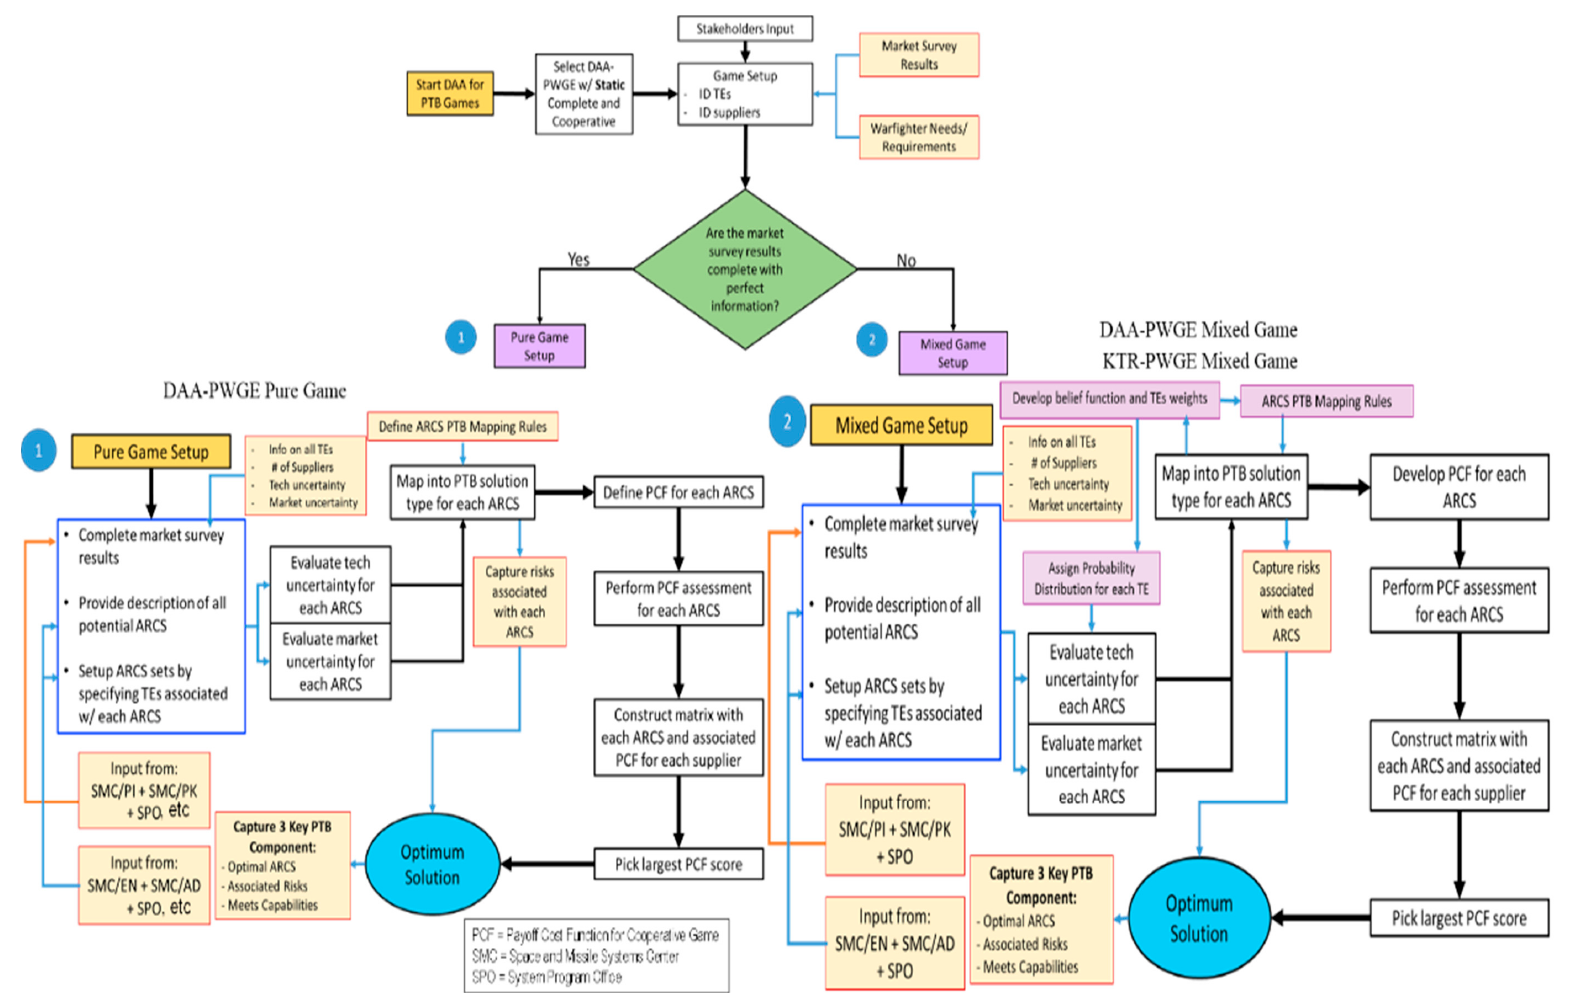
Figure 6. Description of DAA-PWGE and KTR-PWGE Algorithms.